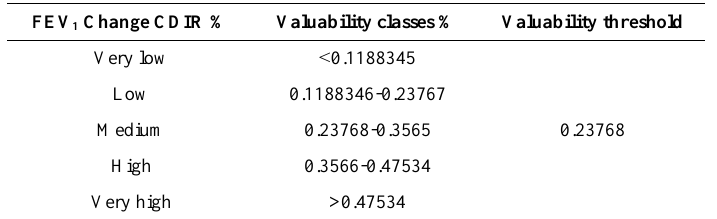
Table 5. FEV 1 Change from baseline CDIR (%) health improvement classification